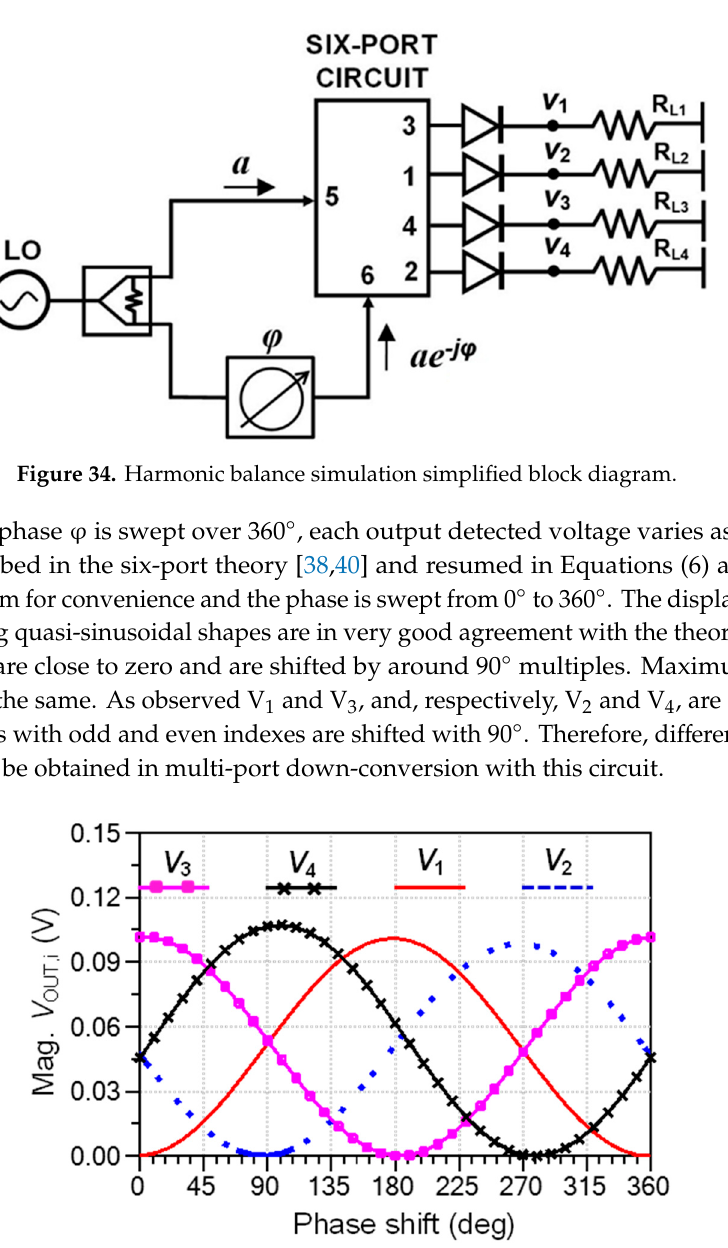
Figure 35. Magnitude of the power detected output voltages (85 GHz).